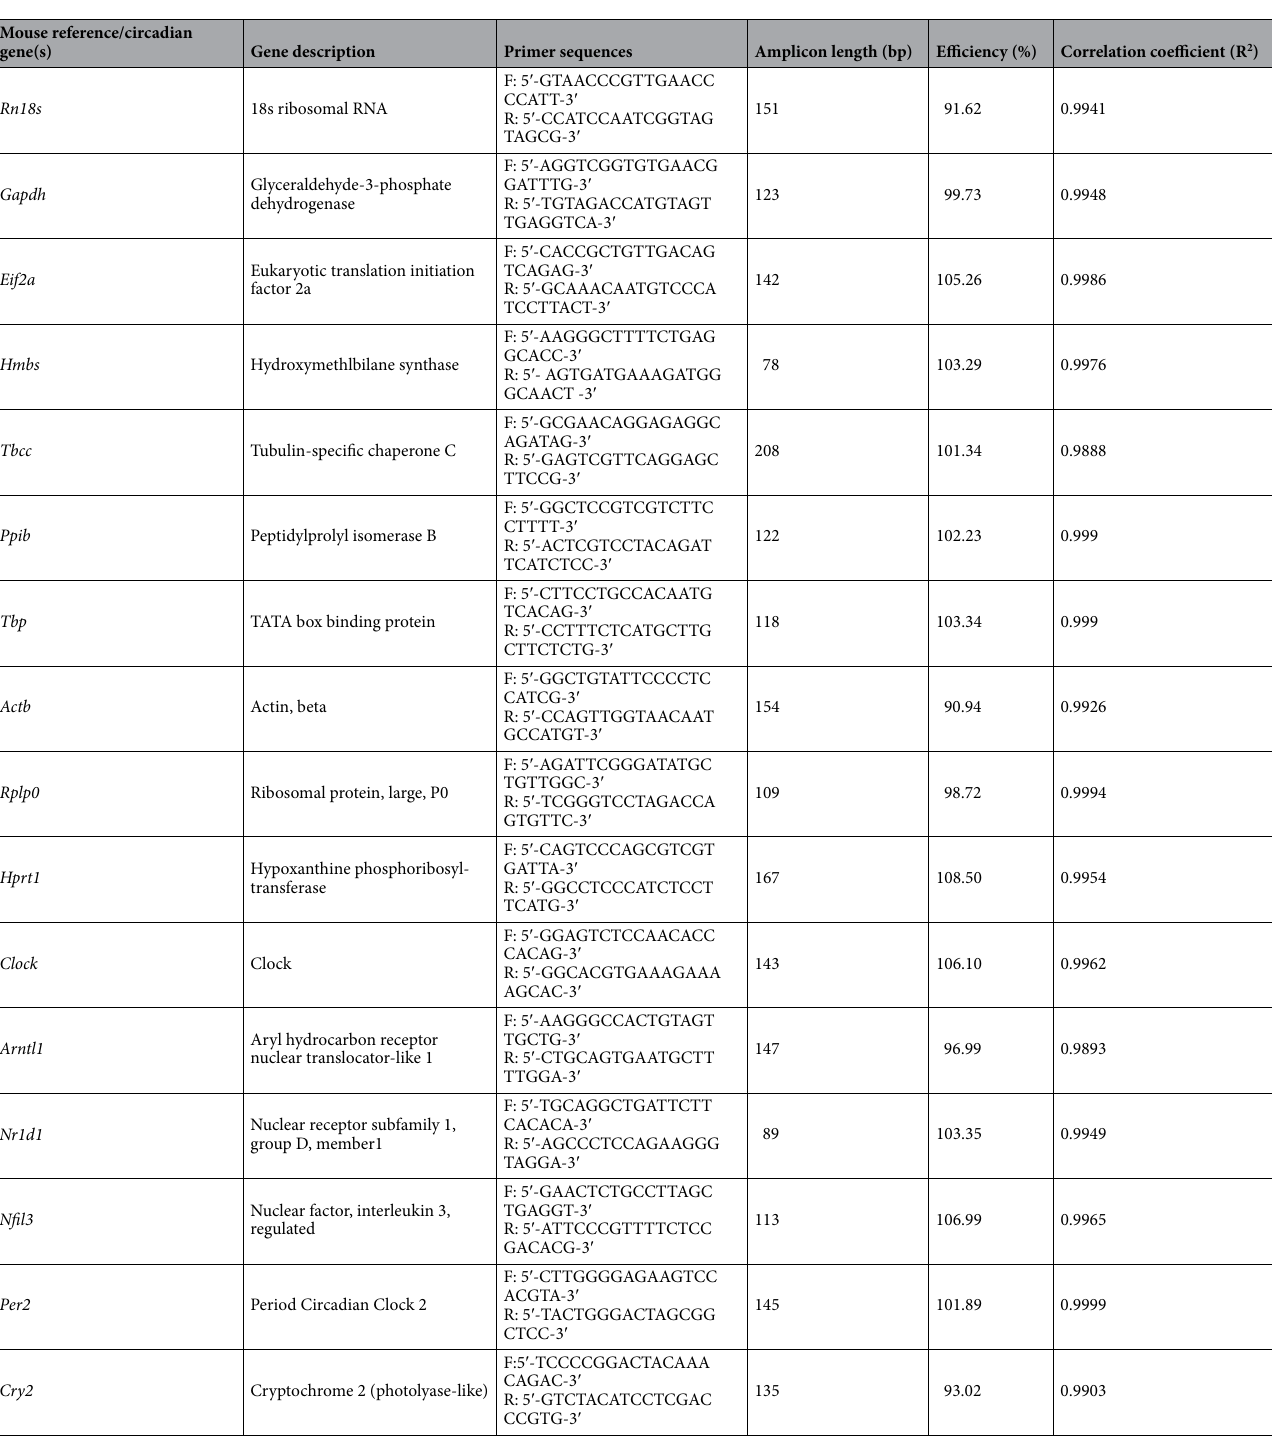
Table 1. Selected mouse housekeeping genes and circadian gene-specific qRT-PCR primer sequences and summary of their amplicon length, efficiency, and correlation coefficient evaluated in this